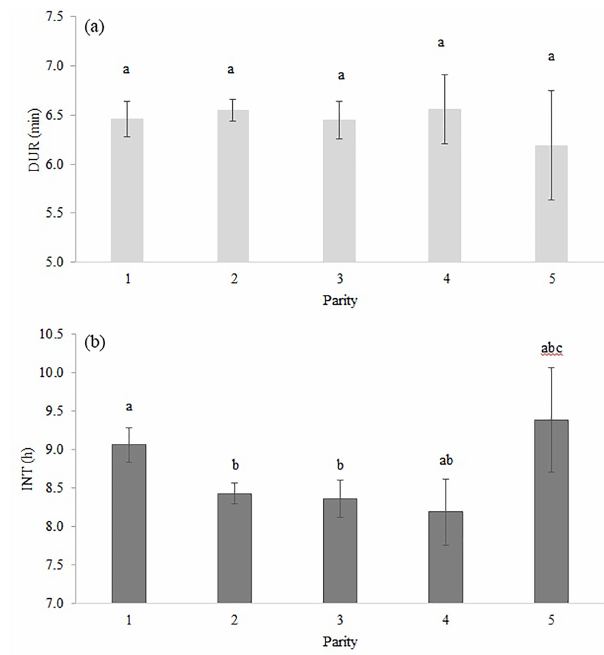
Figure 2. Least squares means for (a) DUR (milking time during a visit in the automatic milking system) ( ± SE) and (b) INT (inter- val between two consecutive milkings) ( ± SE) with dependency on parity. Significant differences of least squares means (<0.05) are indicated with different letters above the